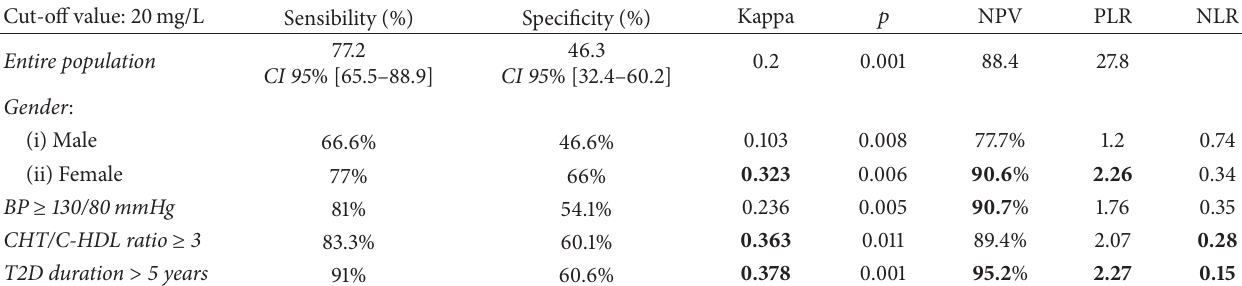
Table 1: Assessment of validity of Micral-test according to subgroups of diabetics.